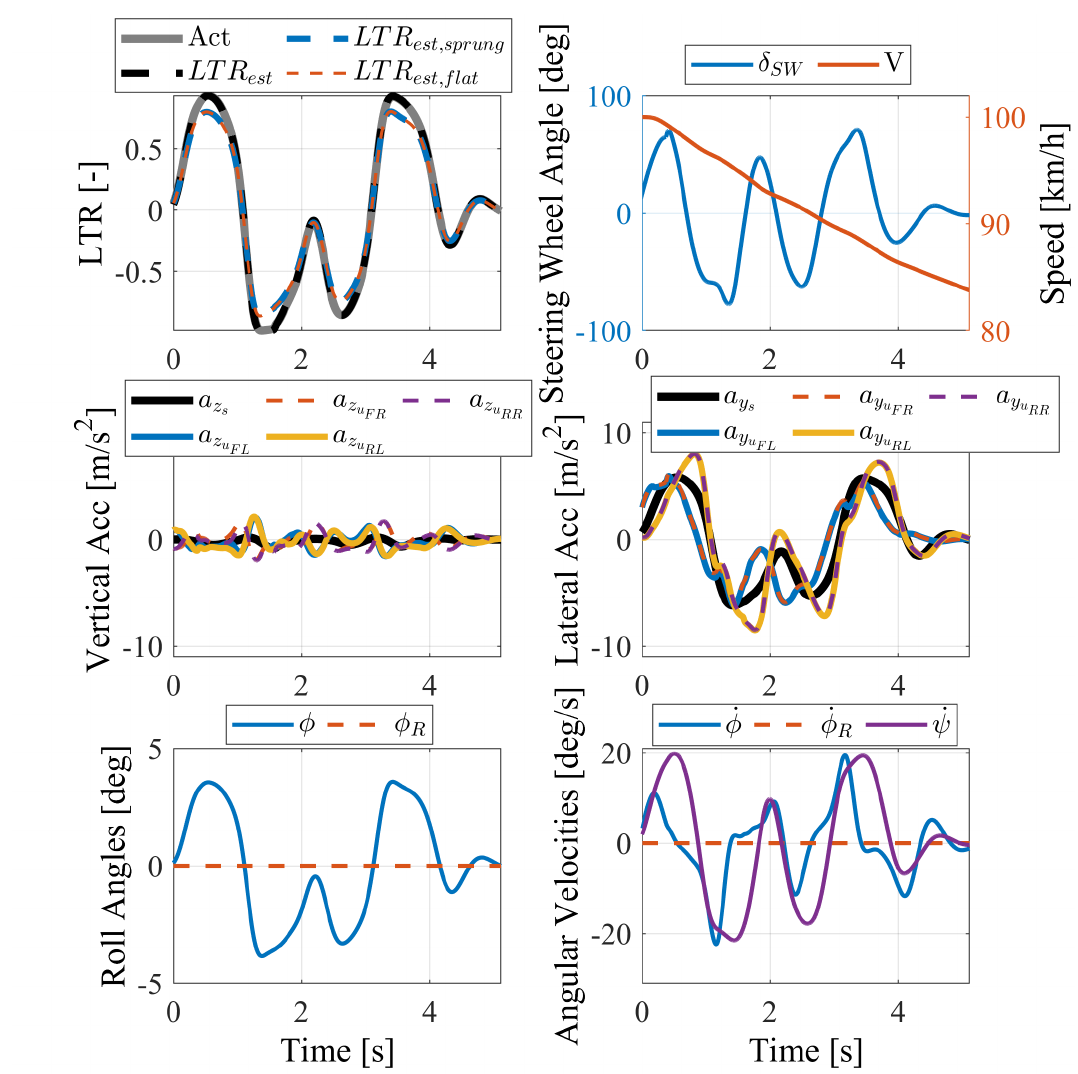
Figure 3. Double lane change manoeuvre at initial speed of 100km/h on a flat road. From the top left side to the down right side: LTR , steering wheel angle and vehicle speed, vertical accelerations, lateral accelerations, roll angles and angular